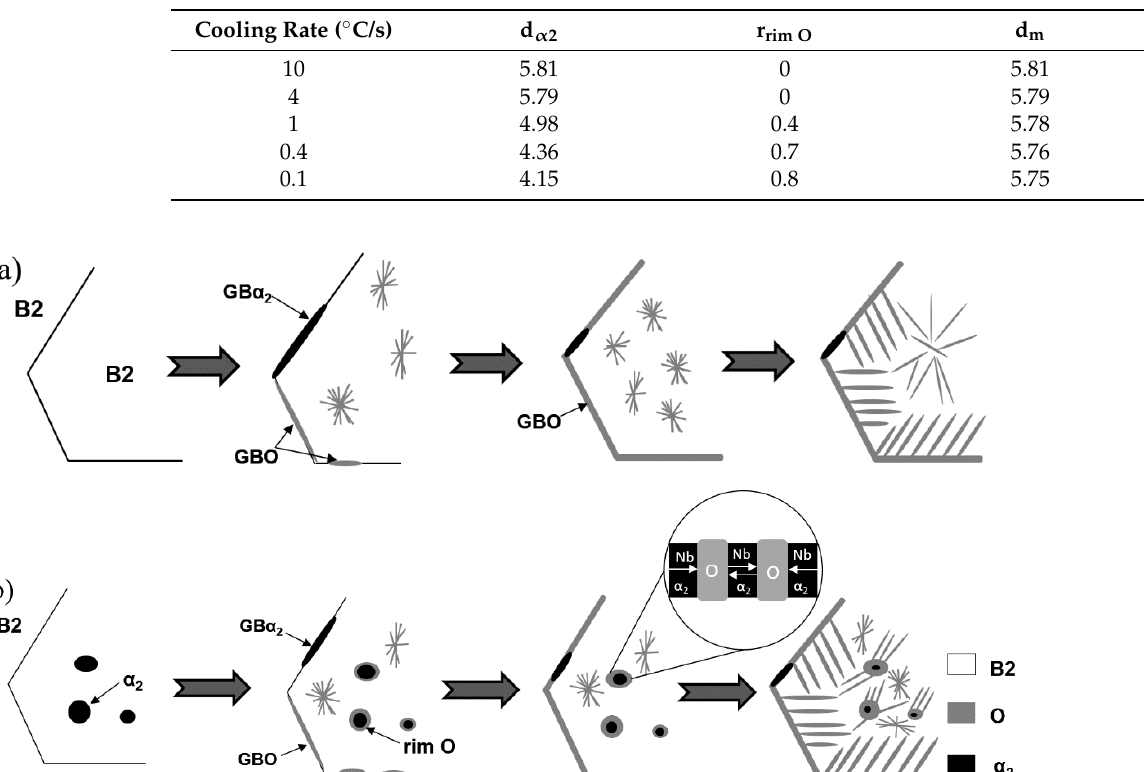
Figure 13. Microhardness versus cooling rate for Ti-22Al-25Nb alloy cooled from different regions. 4. Conclusions In summary, the present research investigated the microstructural evolution of the O phase in a Ti-22Al-25Nb (at.%) alloy during cooling at different cooling rates from differ- ent phase regions. It also summarized the precipitated formation mechanism of the O phase on B2 grain boundaries and within B2 grains and α 2 grains. The main conclusions of this paper are as follows: